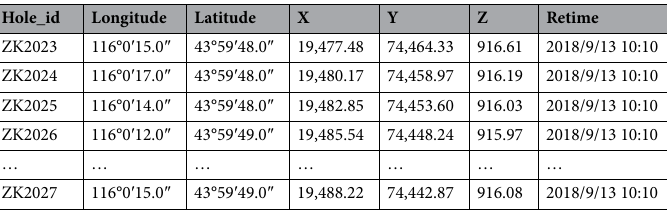
Table 2. Blast hole table.